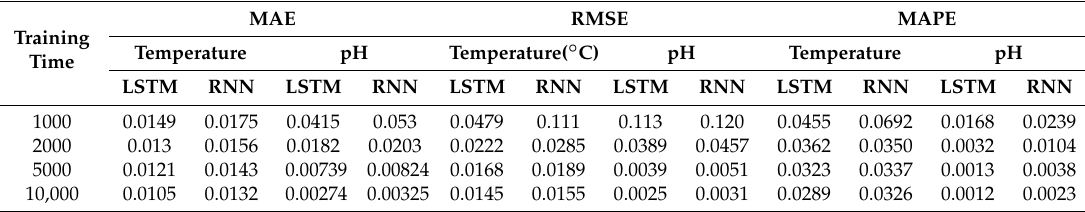
Figure 6. The complete flowchart of the water quality prediction model. Table 2. Records of MAE, RMSE, and MAPE when training time reached specific value.